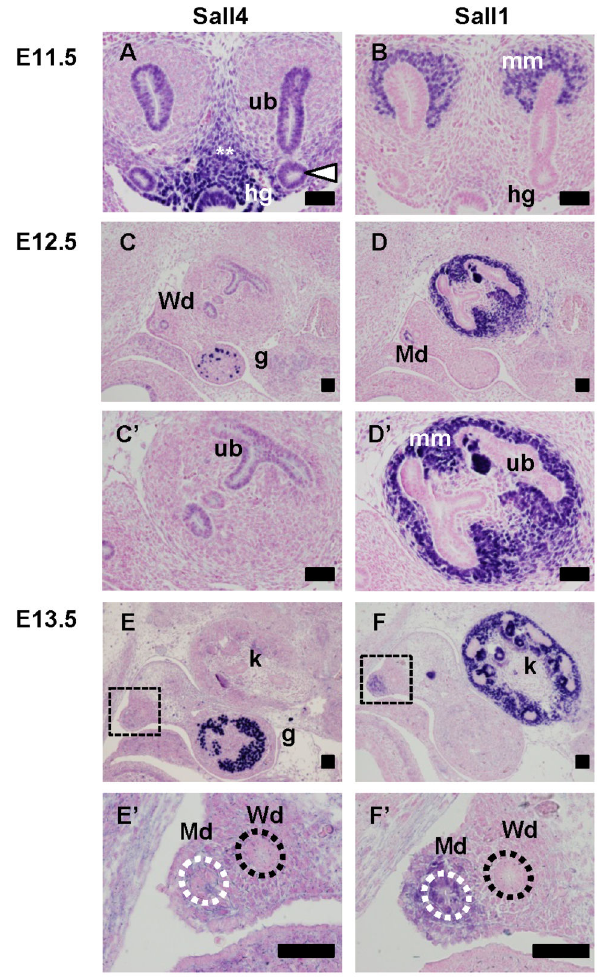
Figure 3. Sall4 is transiently expressed in the ureteric bud from E11.5 to E12.5. (A, B) Sall4 and Sall1 staining of E11.5 kidneys. (C, D) Sall4 and Sall1 staining of E12.5 urogenital regions. (C’, D’) Higher magnification of the kidneys in panels C and D, respectively. (E, F) Sall4 and Sall1 staining of E13.5 urogenital regions. (E’, F’) Higher magnification of the squares in panels E and F, respectively. White arrowhead: caudal end of the Wolffian duct; white double asterisk: tissues surrounding kidney primordia and hindgut; white dotted line: Müllerian duct; black dotted line: Wolffian duct; g: gonad; hg: hindgut; k: kidney; Md: Müllerian duct; mm: metanephric mesenchyme; ub: ureteric bud; Wd: Wolffian duct. Scale bars: 50 µm. doi: